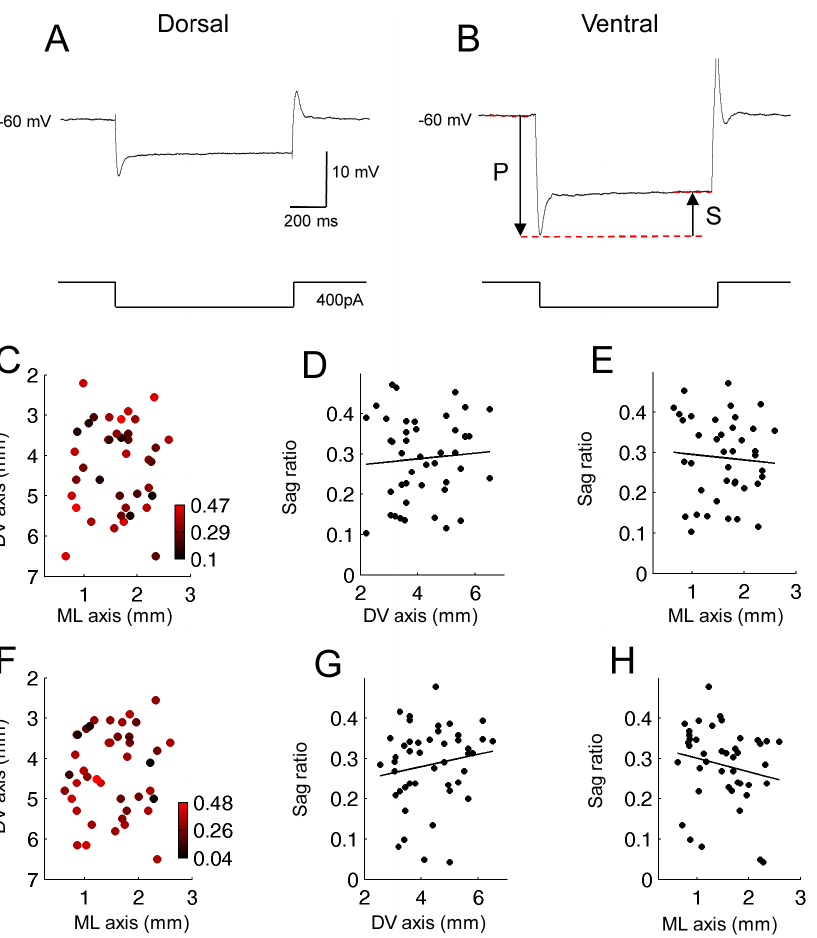
Figure 6. Sag potential does not systematically change along the DV and ML axis. (A and B) Examples of sag potential in the normal ACSF in a dorsal (A) and a ventral cell (B). Sag ratio was calculated by dividing the steady state potential (indicated by arrow S) by the peak potential (indicated by arrow P). The sag ratios were similar in dorsal and in ventral cells. (C) Color plot of the sag ratio at different positions in the two- dimensions (DV and ML) of anatomical space in normal ACSF. (D and E) Sag ratio along the DV and ML axis, respectively, in normal ACSF. (F) Color plot of the sag ratio at different positions in the two-dimensions (DV and ML) of anatomical space in carbachol (10 m M). (G and H) Sag ratio along the DV and ML axis, respectively, in carbachol.